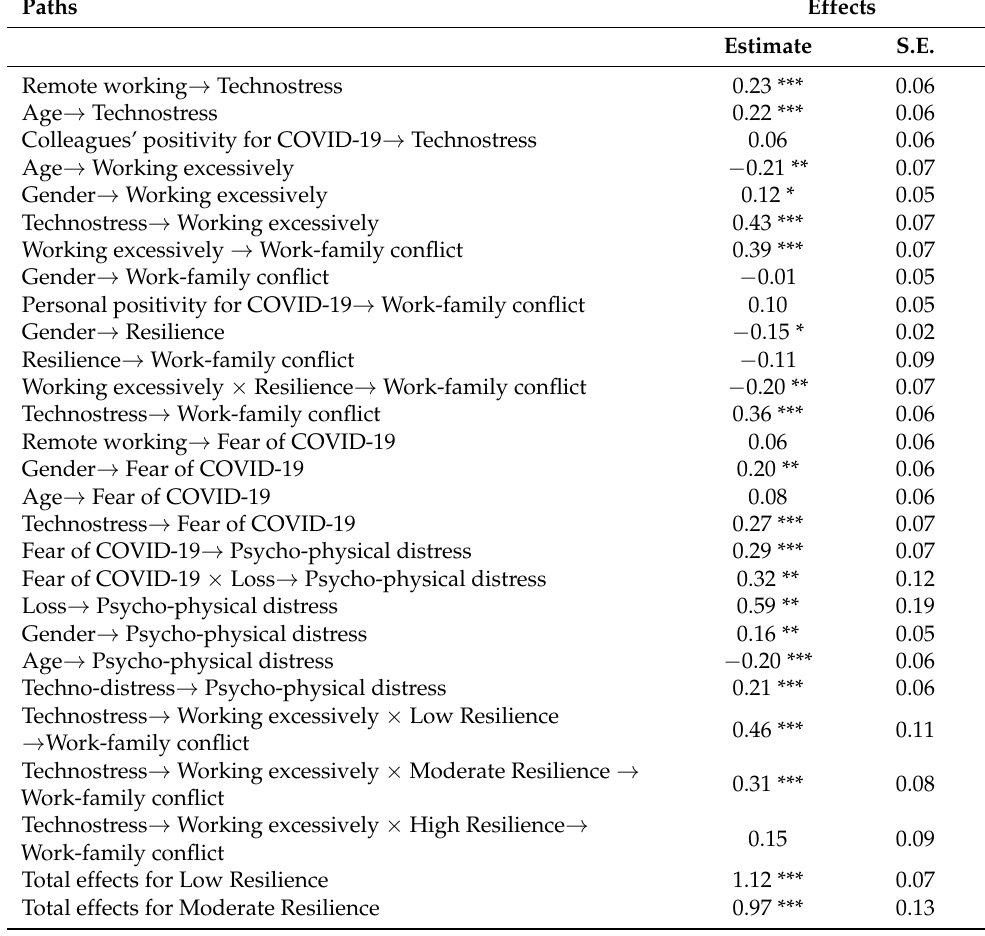
Figure 3. Moderating effects of resilience on the relationship between working excessively and work-family conflict .